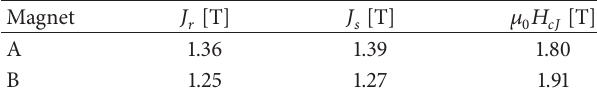
Table 1: Magnetic properties of the investigated sintered Nd-Fe-B magnets, measured with a HIRST pulsed field magnetometer. Magnet